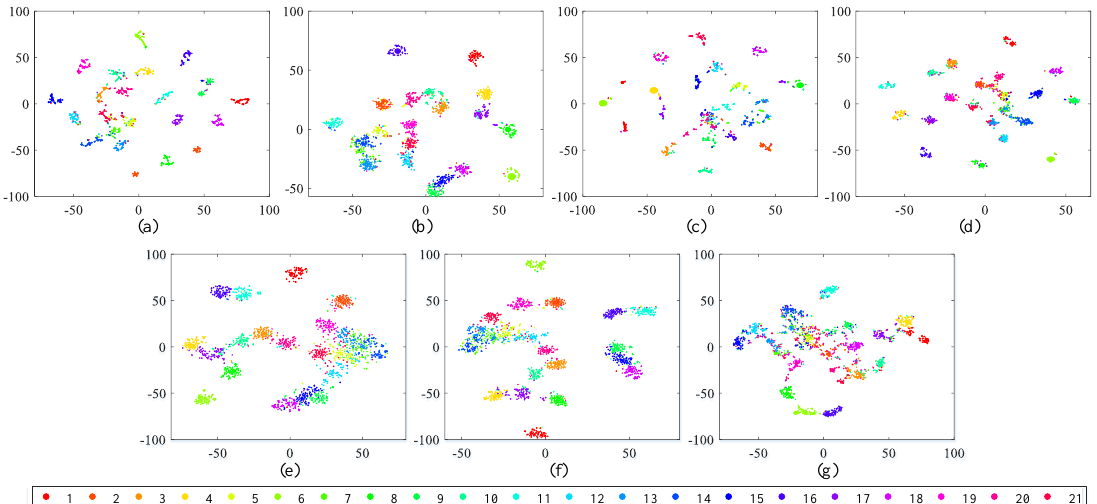
Figure 14. Two-dimensional scatterplots of different hash codes (128 bits) obtained by t-SNE over UCM with 21 semantic scenes. The relationships between number ID and scenes can be found in Table 1: ( a ) SDAH (Our method); ( b ) SSDH; ( c ) BTNSPLH; ( d ) KSH; ( e ) DQH; ( f ) DHN; and ( g ) DSH.